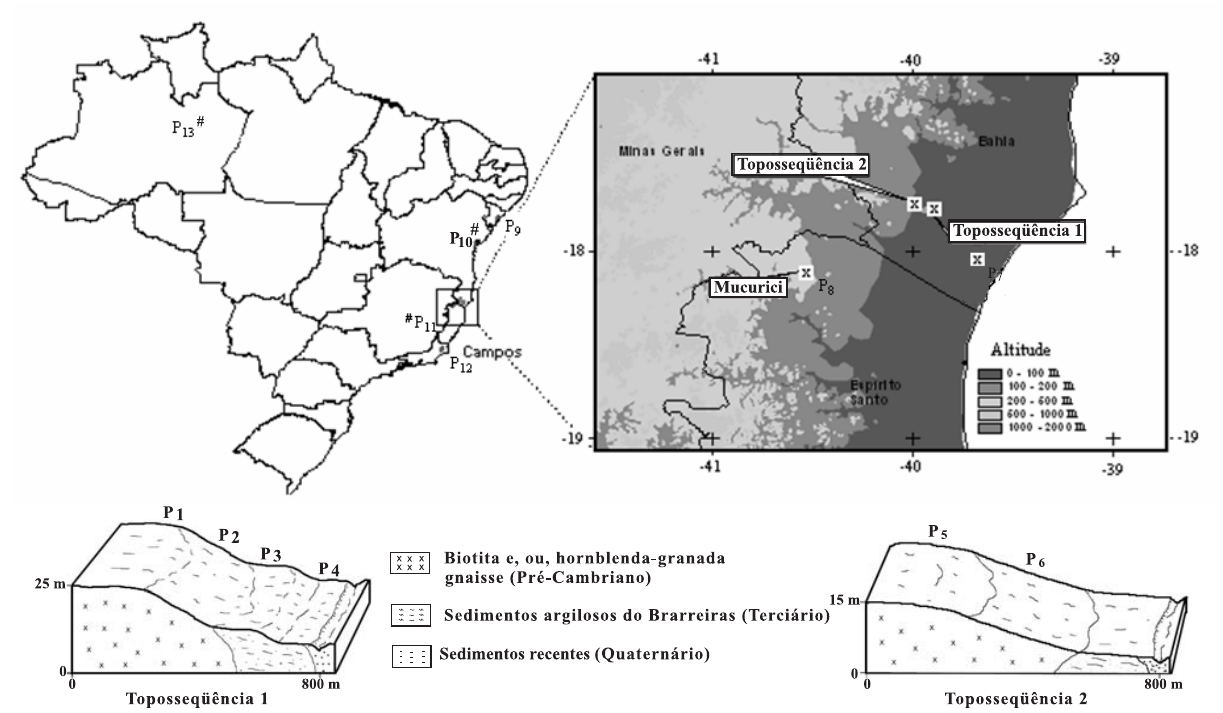
Figura 1. Localização dos perfis coletados e representação de suas